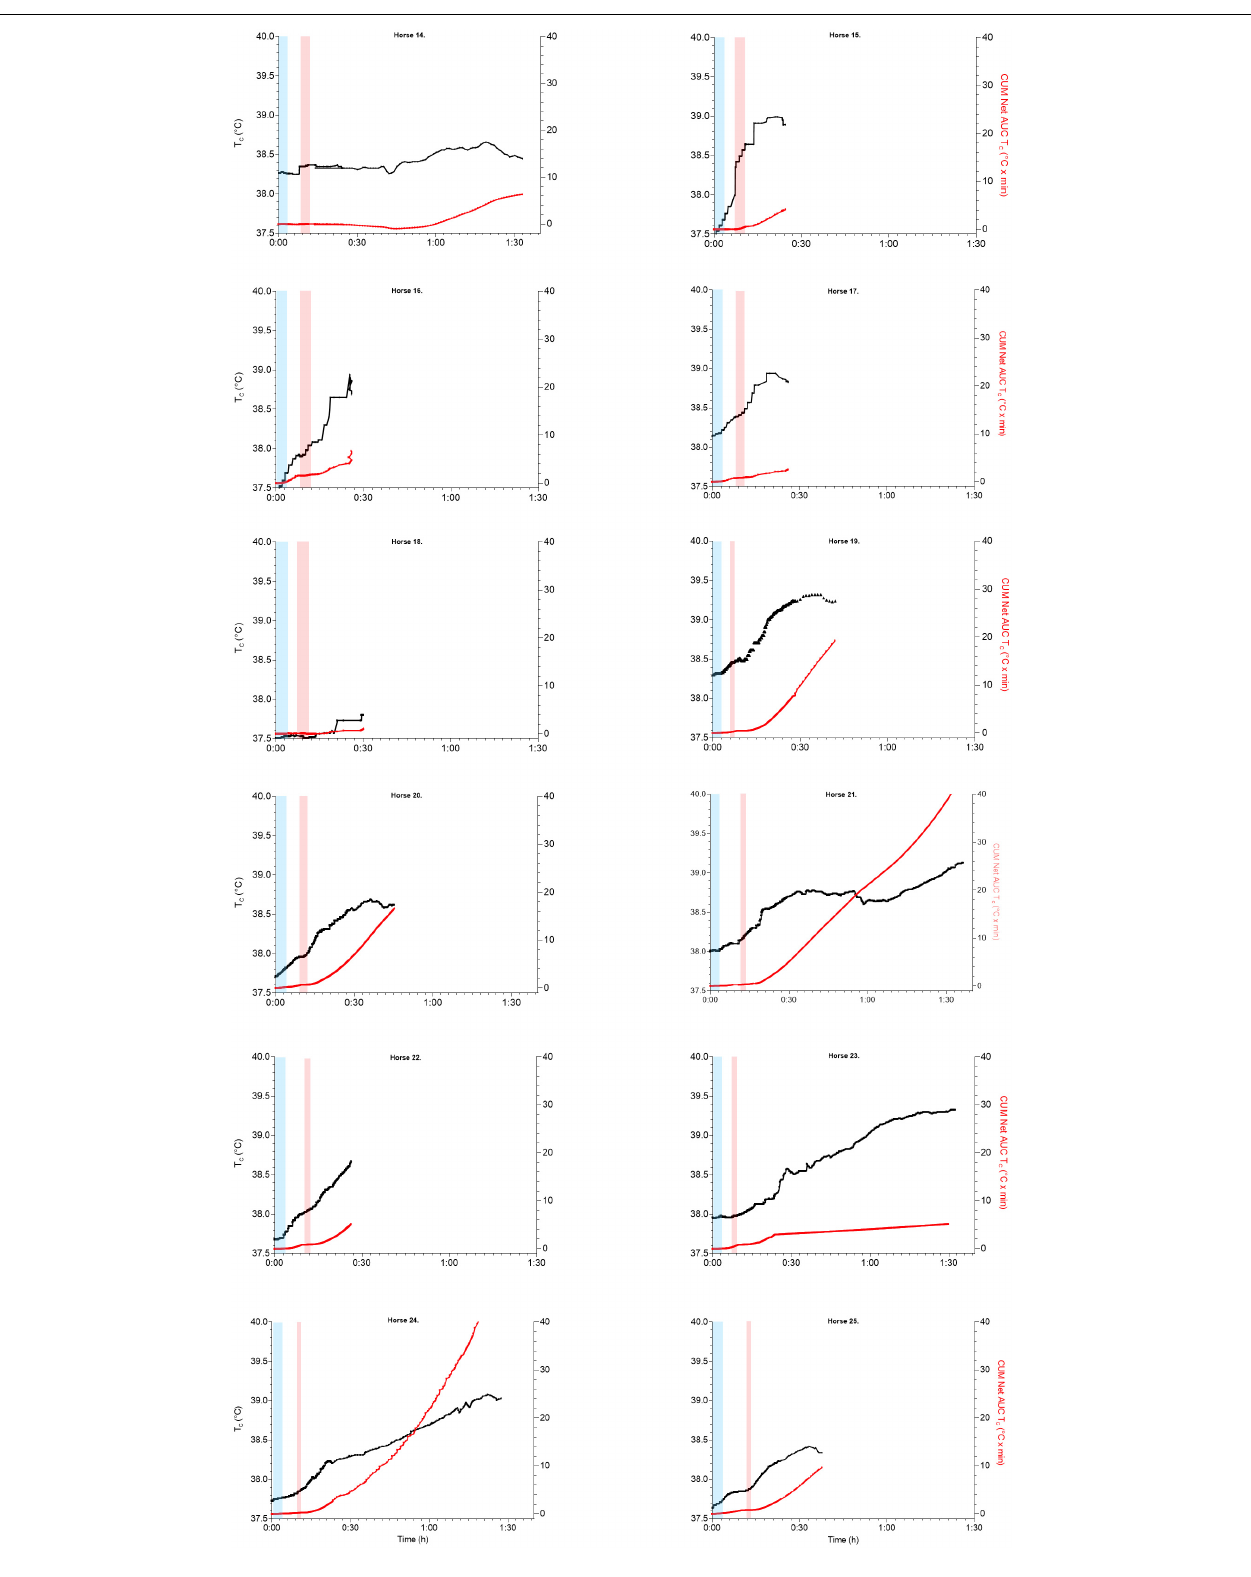
Frontiers in Physiology |